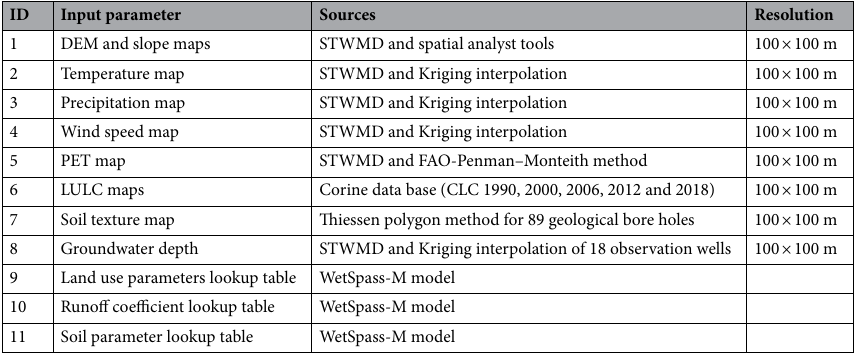
Table 1. Input data and sources for WetSpass-M